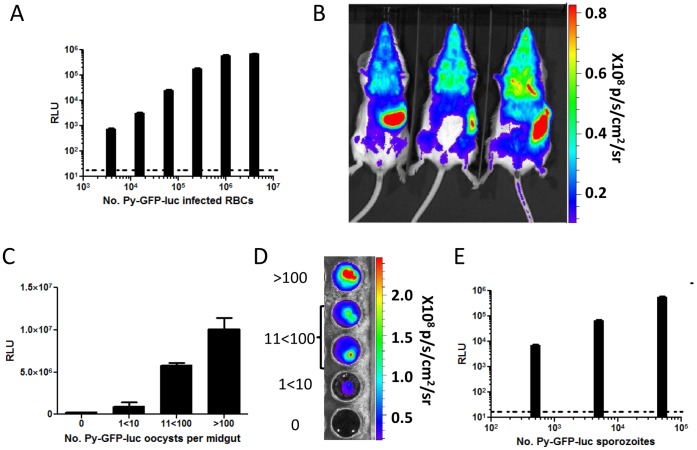
Luciferase activity of the Py-GFP-luc parasite.(A, B) Luminescence during erythrocytic stages. (A) Py-GFP-luc infected red blood cells were serially diluted 1∶4 in RPMI and were mixed with an equal volume of luciferin. Luminescence (relative light units, RLU) was measured with a Centro microplate reader. Dashed line indicates background luminescence as determined by measuring uninfected RBCs. (B) Rainbow images of luminescence in BALB/cJ mice with Py-GFP-luc blood stage parasitemia. Mice were injected with luciferin and imaged. Bioluminescence was measured in total flux (p/s). (C, D) Luminescence of Py-GFP-luc oocysts. (C) Midguts from Py-GFP-luc infected mosquitoes were isolated 10 days after an infectious blood meal. The number of oocysts per midgut was estimated and midguts were categorized as follows: Uninfected (0), between 1 and 10 oocysts/midgut (1<10), between 11 and 100 oocysts/midgut (11<100), and greater than 100 oocysts/midgut (>100). Luciferase activity from individual midguts was determined using the Centro microplate reader (RLU) (C) and the IVIS animal imager (total flux) (D). (E) Luminescence of Py-GFP-luc sporozoites. Sporozoites were isolated from salivary glands of infected mosquitoes and serially diluted 1∶10 in RPMI. Luminescence (RLU) was determined as in (A). Dashed line indicates background luminescence of RPMI.